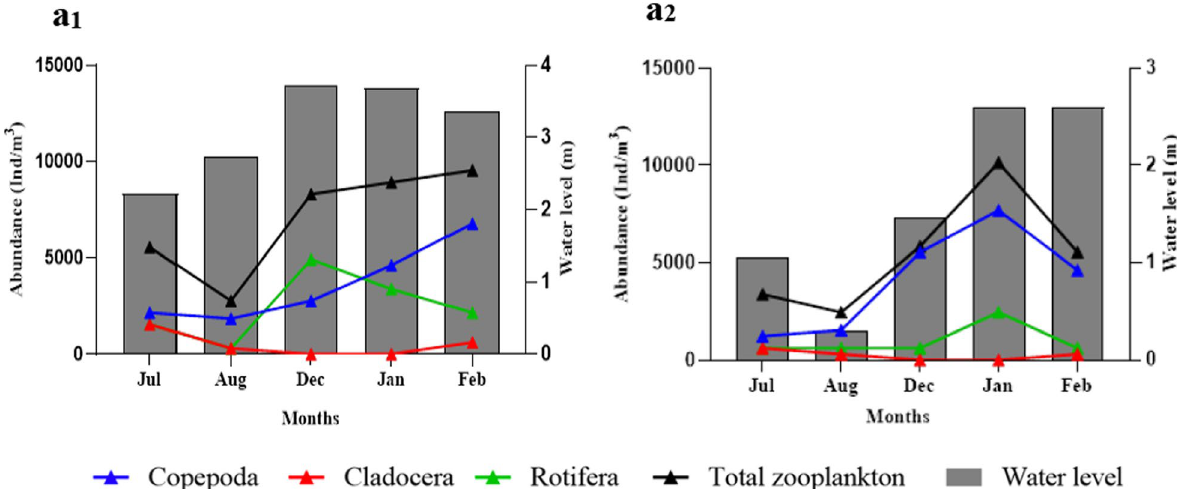
Fig. 9 Zooplankton abundance fluctuation with water level during July 2018–February 2019. a1 Vavuniya reservoir. a2 Thandikulam